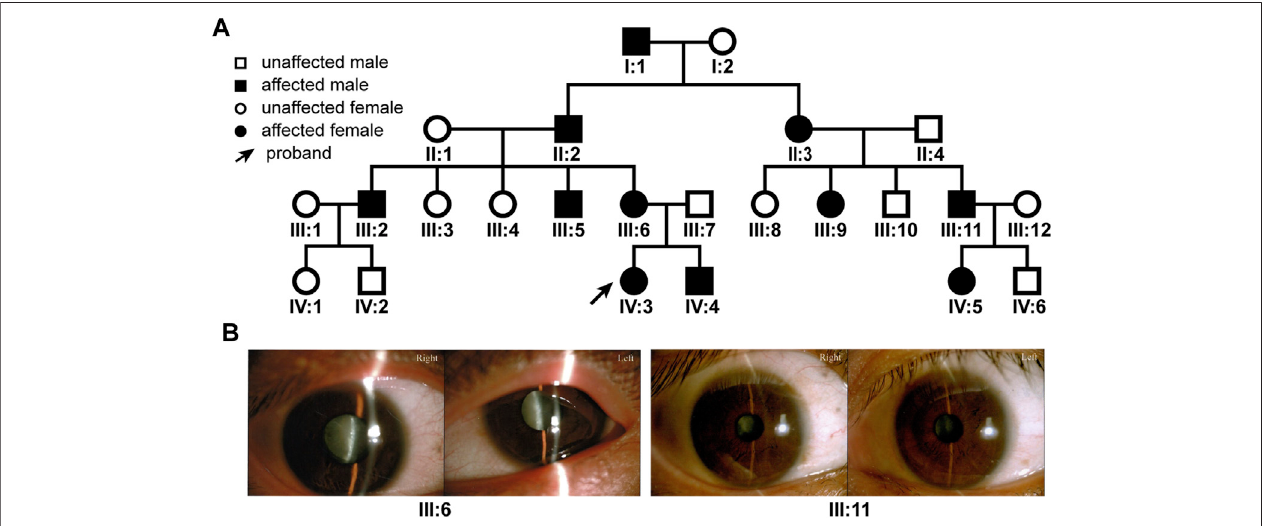
FIGURE 1 | The family tree of the patient pedigree and cataract phenotype. (A) The four-generation 24-member pedigree with dominant congenital cataract. (B) Varied cataract types and severity in patients. Photographs of eyes of two patients were shown. Patient III:6 has bilateral total cataracts. Patient III: 11 has a nuclear cataract in the right eye and a zonular cataract in the left eye.